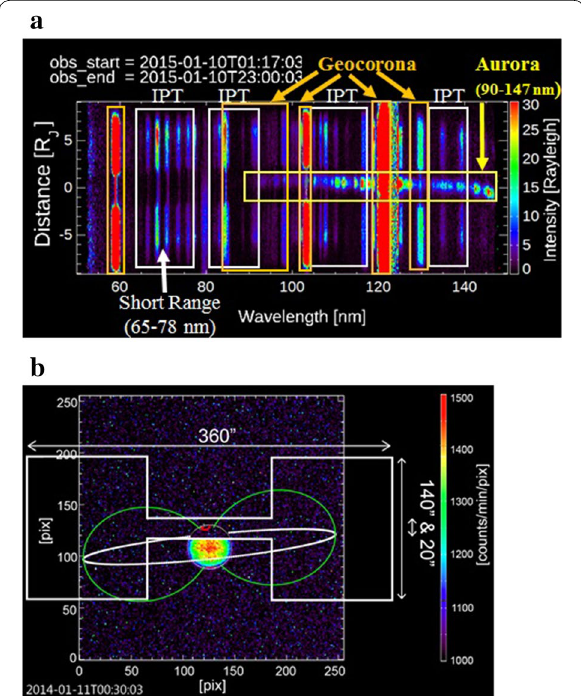
Fig. 2 a A typical EUV spectrum (53–147 nm) measured by the Hisaki spacecraft before the volcanic eruption. The spectrograph mixes spatial and spectral information on the X -axis, whereas the spatial information on the equatorial plane is represented on the Y -axis. Three types of origins are observed: Jupiter’s aurora, IPT, and geo- corona. b The slit shape of Hisaki and its position relative to Jupiter. The uniquely shaped slit is superimposed on the real, visible image of Jupiter taken by the Field-of-View guidance camera on Hisaki. The white arc represents the Io orbit at 6 R J . The two green lines are Jovian magnetic field lines that reach the Io